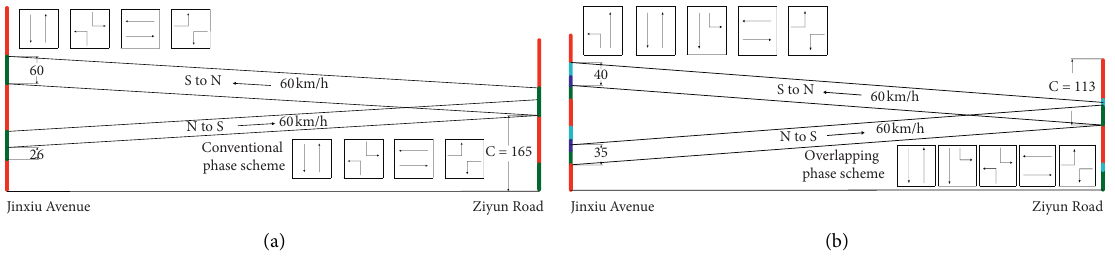
Figure 4: Designs of the two-way green wave time-distance diagrams and the phase schemes: (a) two-way coordination scheme based on conventional phase and (b) two-way coordination scheme based on the overlapping